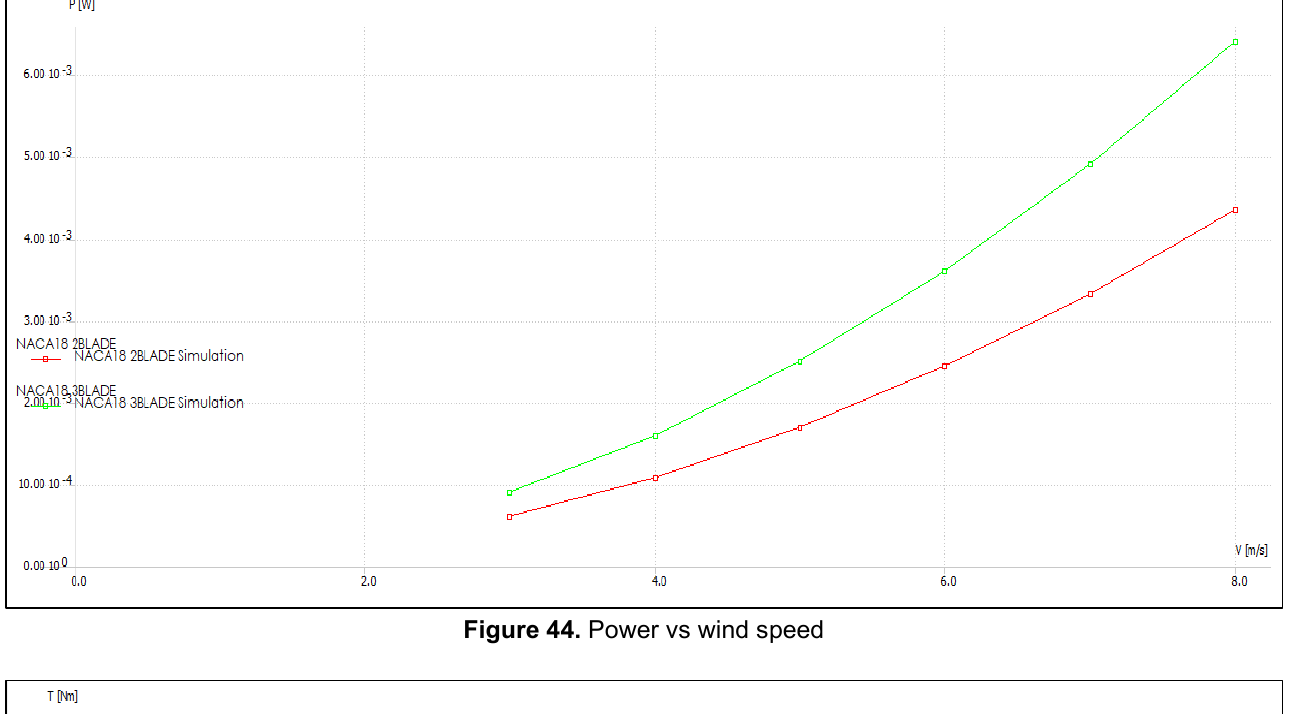
Figure 44. Power vs wind speed